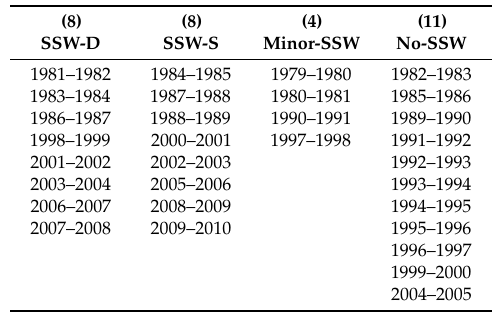
Table 1. Classification of 31-winters (1979–2010) into SSW-D, SSW-S, Minor-SSW and